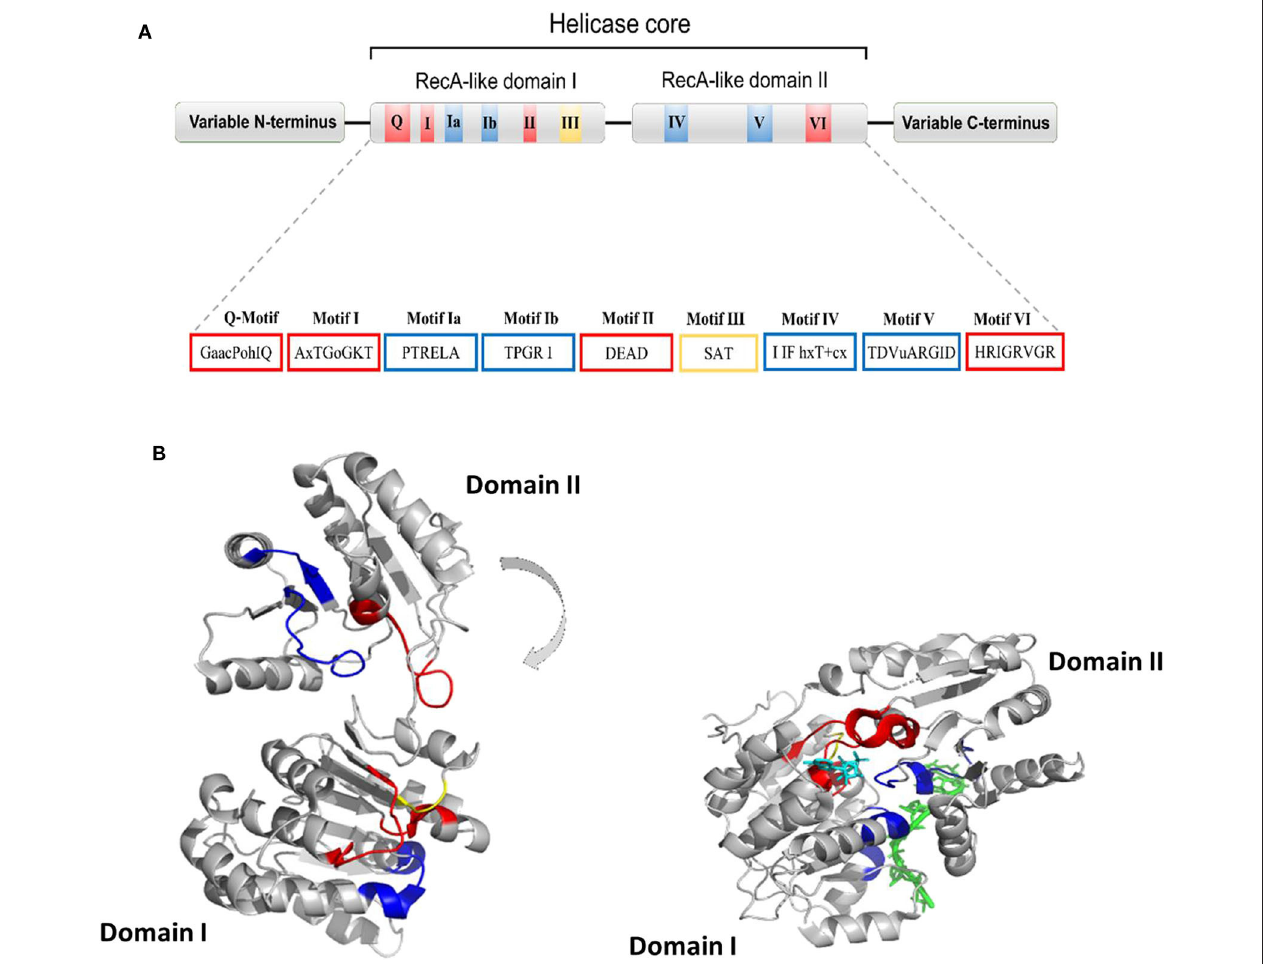
FIGURE 5 | (A) Typical domain organization of DDX helicases. The motifs are shown with colors according to their primary function (red, ATP binding and hydrolysis; yellow, coordination between NTP- and RNA-binding sites; blue, RNA binding). (B) Cartoon representation showing domain movements in DDX helicases upon RNA binding of the DEAD-box protein eIF4AIII without RNA (left) and in complex with RNA (right). An RNA fragment and AMPPNP are shown in stick representation in green and in cyan,